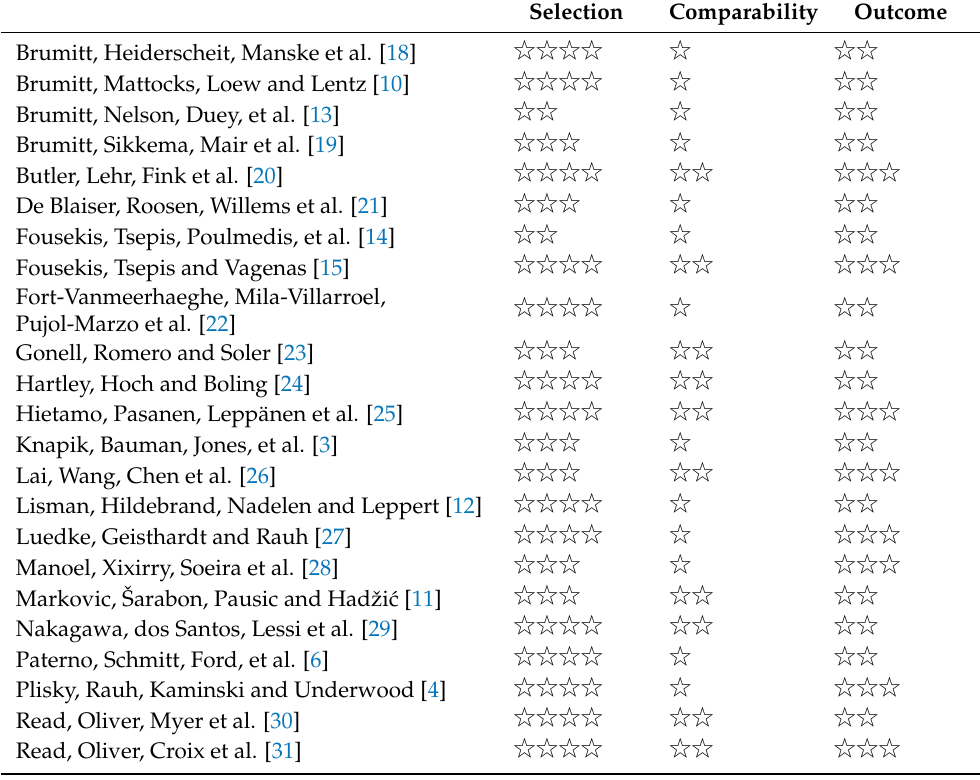
Table 1. Study quality assessment with the Newcastle–Ottawa